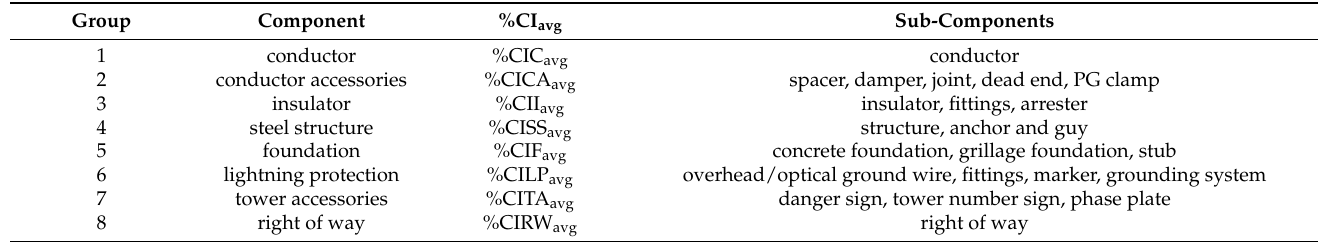
Table 1. Transmission line components.